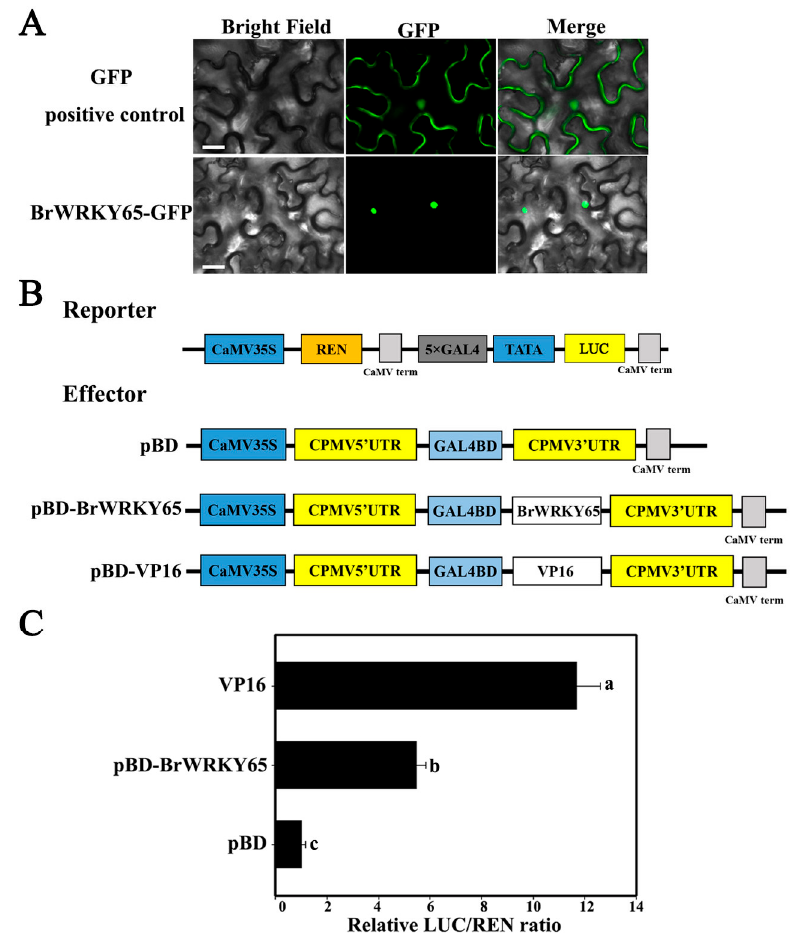
Figure 3. ( A ) Nuclear localization of BrWRKY65 in tobacco leaves. The fusion protein (BrWRKY65-GFP) and positive control were transiently expressed in tobacco leaves respectively via Agrobacterium tumefaciens strain GV3101. GFP signals were captured with a fluorescence microscope after 48 h of injection. Images were photographed in a dark-field for GFP, while the outline of the cell and the merged were taken in a bright field. Bars, 25 μ m; ( B ) Schematics of the reporter and effector constructs. The firefly luciferase (LUC) was drove by the minimal TATA box of the CaMV 35S promoter plus five copies of the GAL4 binding element (5 × GAL4), and the CaMV 35S-driving Renilla luciferase (REN) at the same vector was used as an internal control. BrWRKY65 fused with the yeast GAL4 DNA-binding domain (GAL4BD) driven by CaMV 35S, were adopted as the effector; ( C ) Transcriptional activation activity of BrWRKY65. The trans-activation ability of BrWRKY65 is revealed by the LUC/REN ratio. The ratio of LUC/REN of the empty pBD vector is used as the calibrator (set as 1). At least six independent repeats were assayed for each pair. Compared with the pBD, significant differences at the level of p < 0.05 analyzed by the Student’s t -test, are indicated by different letters above the bar.